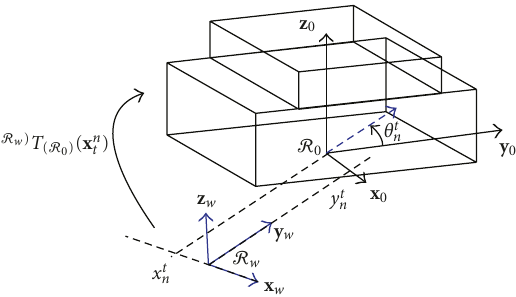
Figure 3: Illustration of the likelihood function. A discrete set of positions of the vehicle into the video sequence is generated from the trajectory sample. A generic 3D model of a vehicle is then pro- jected into each image and compared to a background/foreground map of the video sequence.